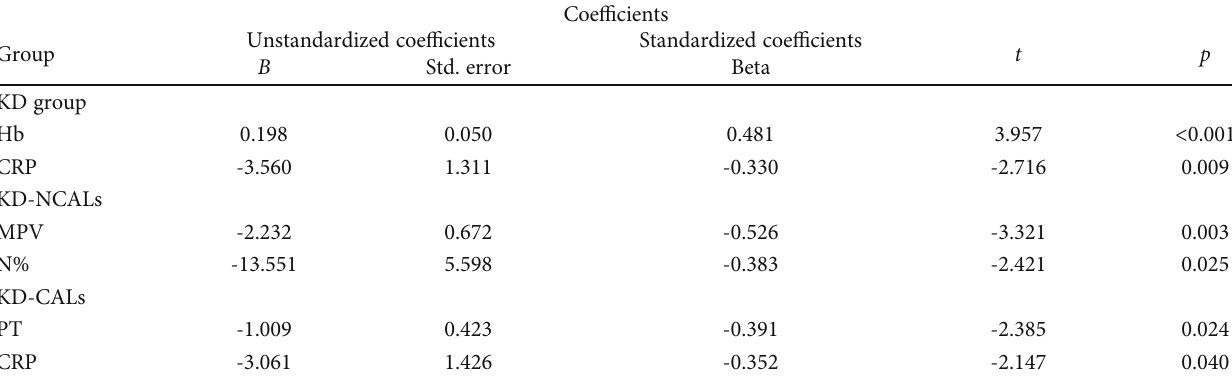
Table 3: Signi fi cant predictors of RBP4 using stepwise linear